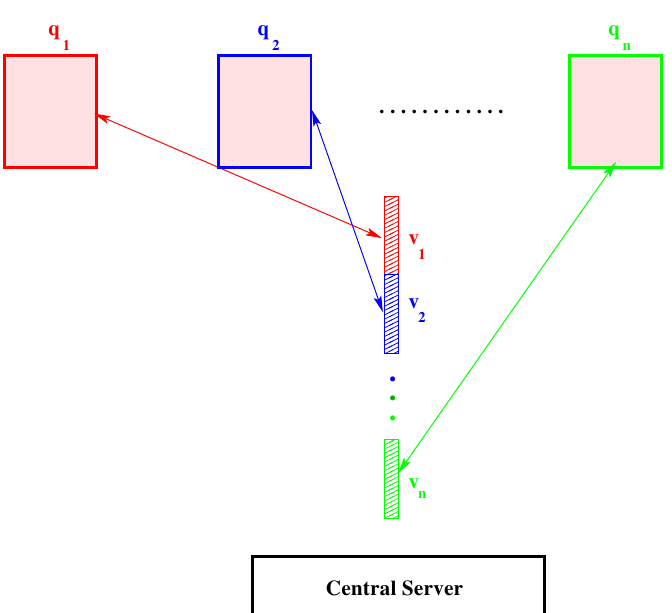
Figure 1. Eigenvalue solver for distributed networks: Data are distributed over the nodes q i , i = 1 · · · n . A piece of eigenvector for each is sent to each node q i , which applies a signature, and the result is collected in a whole eigenvector in the central